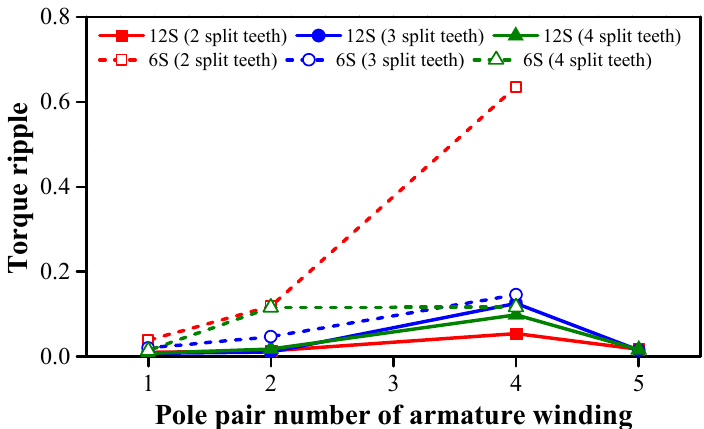
Figure 15. Torque ripples versus stator slot number, armature pole pair number, and split-tooth number when rotor slot number is selected as nN s − P a .